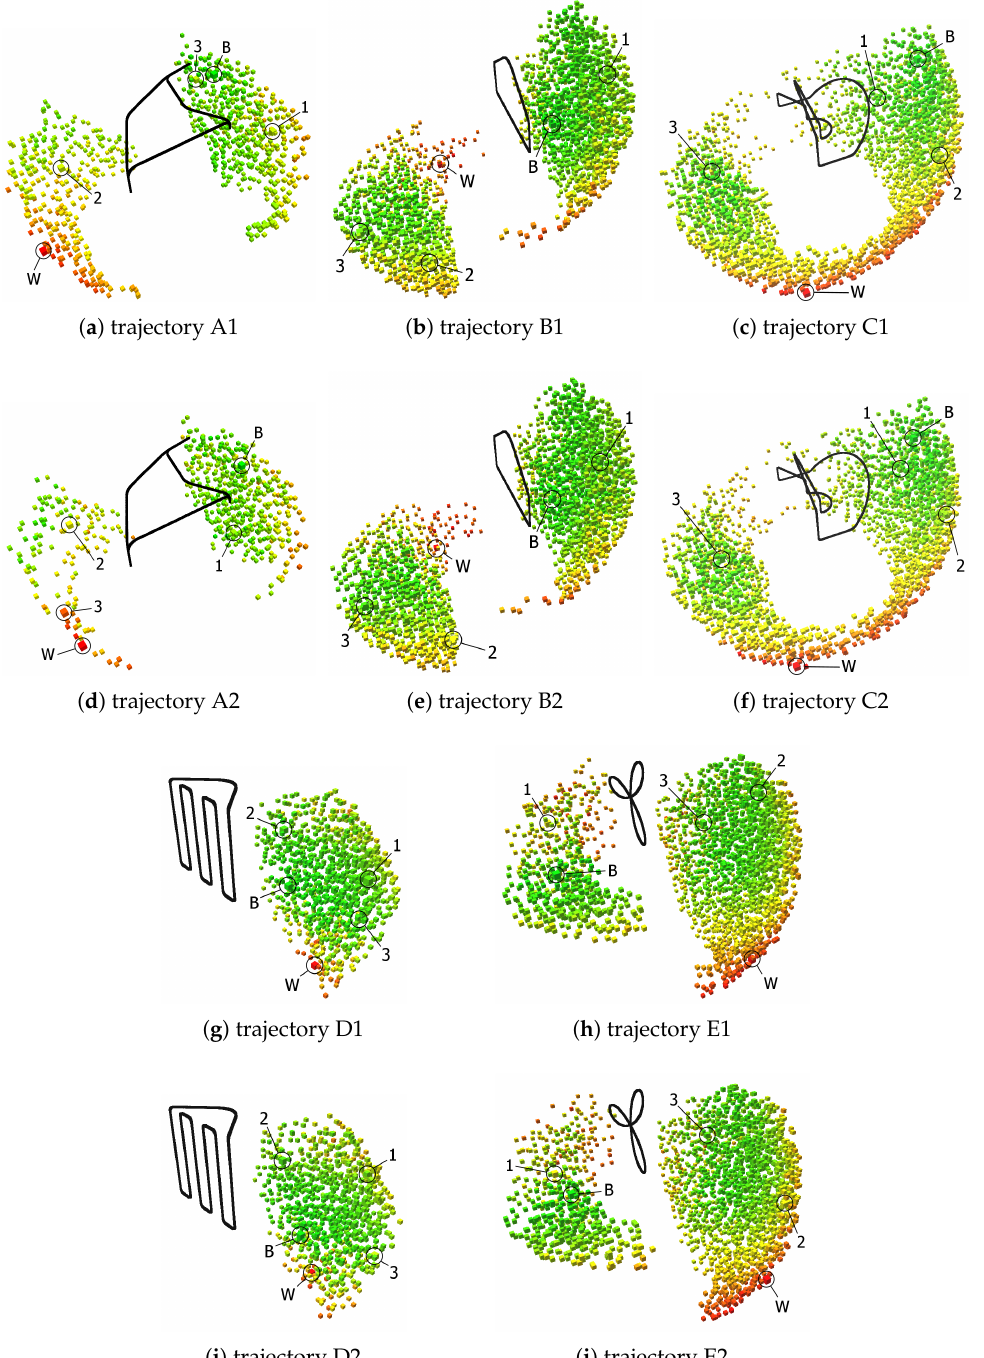
Figure 6. All valid robot locations in the grid; the color-coding indicates the f f values using the gradient red–yellow–green, where green is the best location (B) and red is the worst (W). Locations numbered 1, 2, and 3 are the three other locations used in the experiment with a real